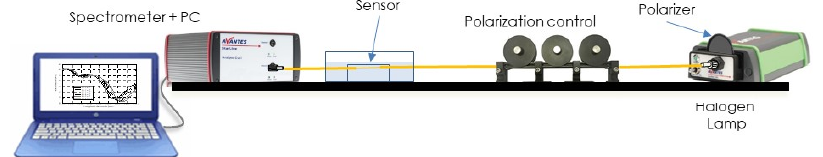
Figure 7. Schematic of the experimental setup for the characterization of the sensors.